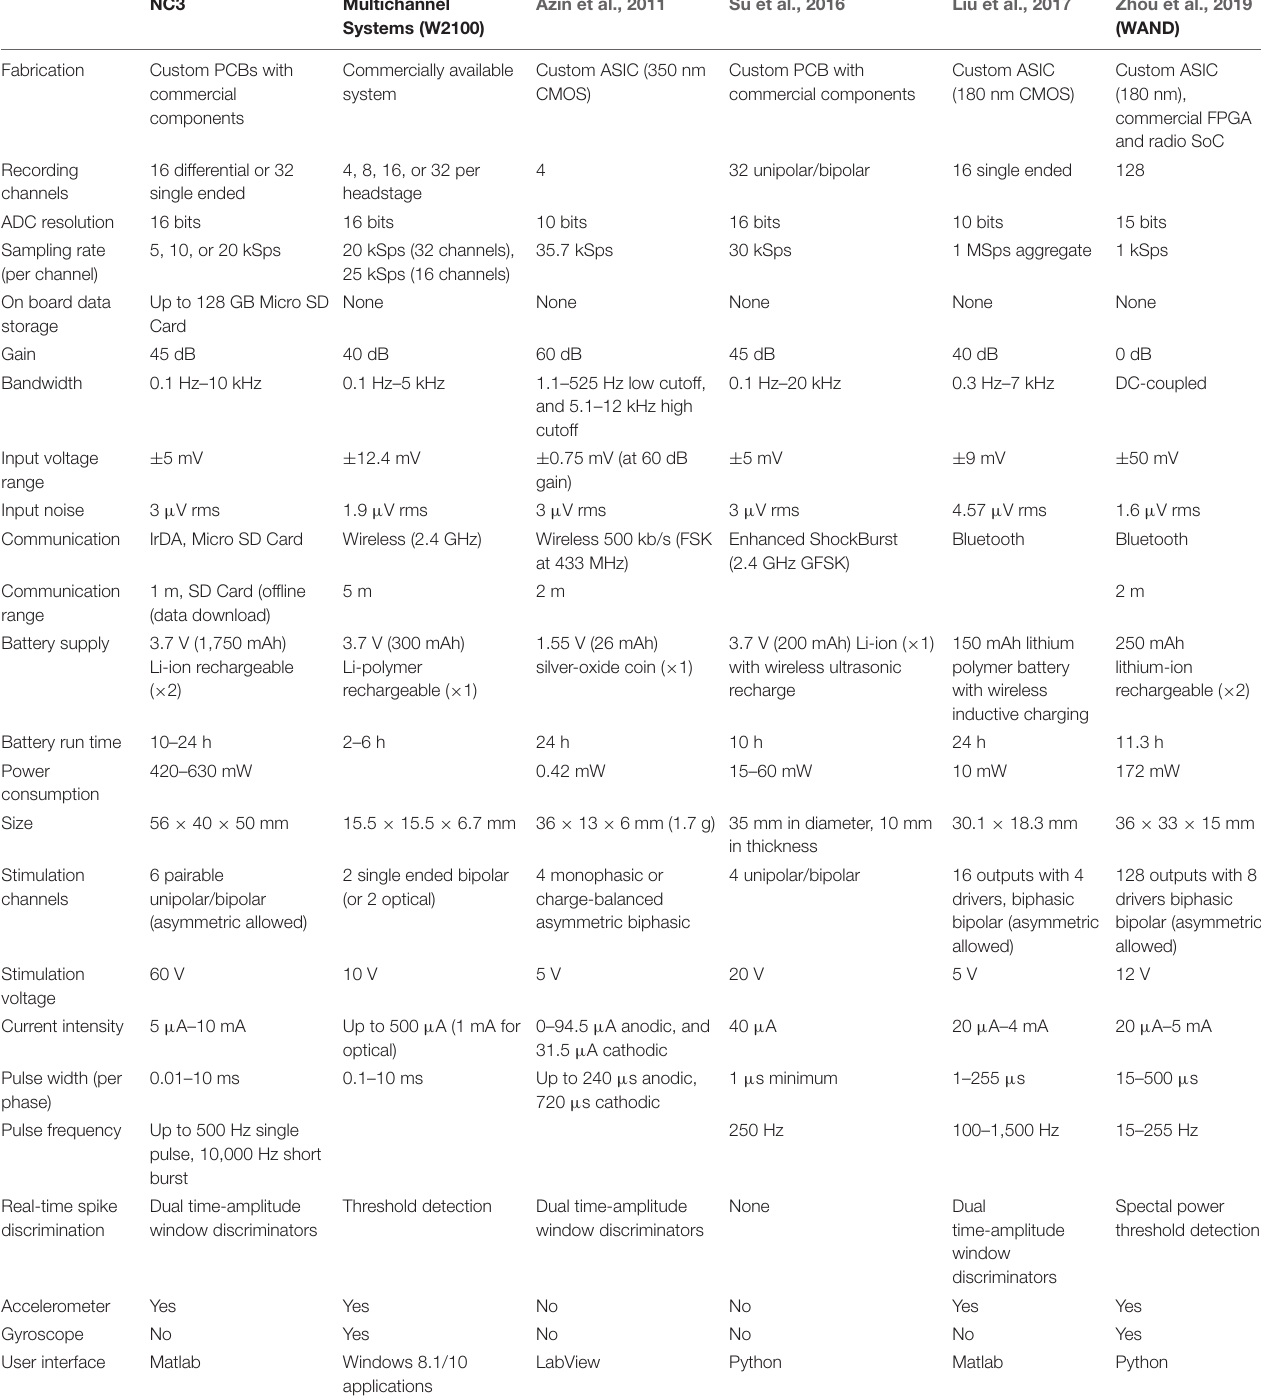
TABLE 2 | Comparison of NC3 to five other